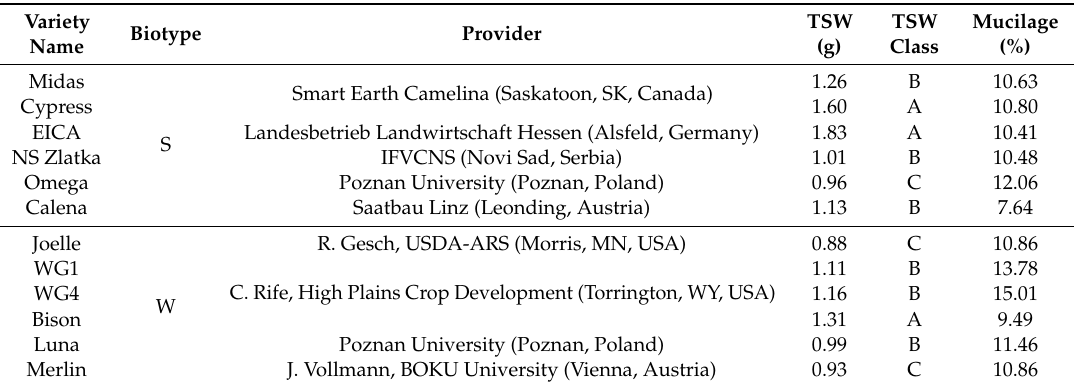
Table 1. List of tested camelina varieties in the germination study with respective seed providers, biotype, thousand seed weight (TSW, g), TSW class, and mean mucilage content (%). Biotype: S =